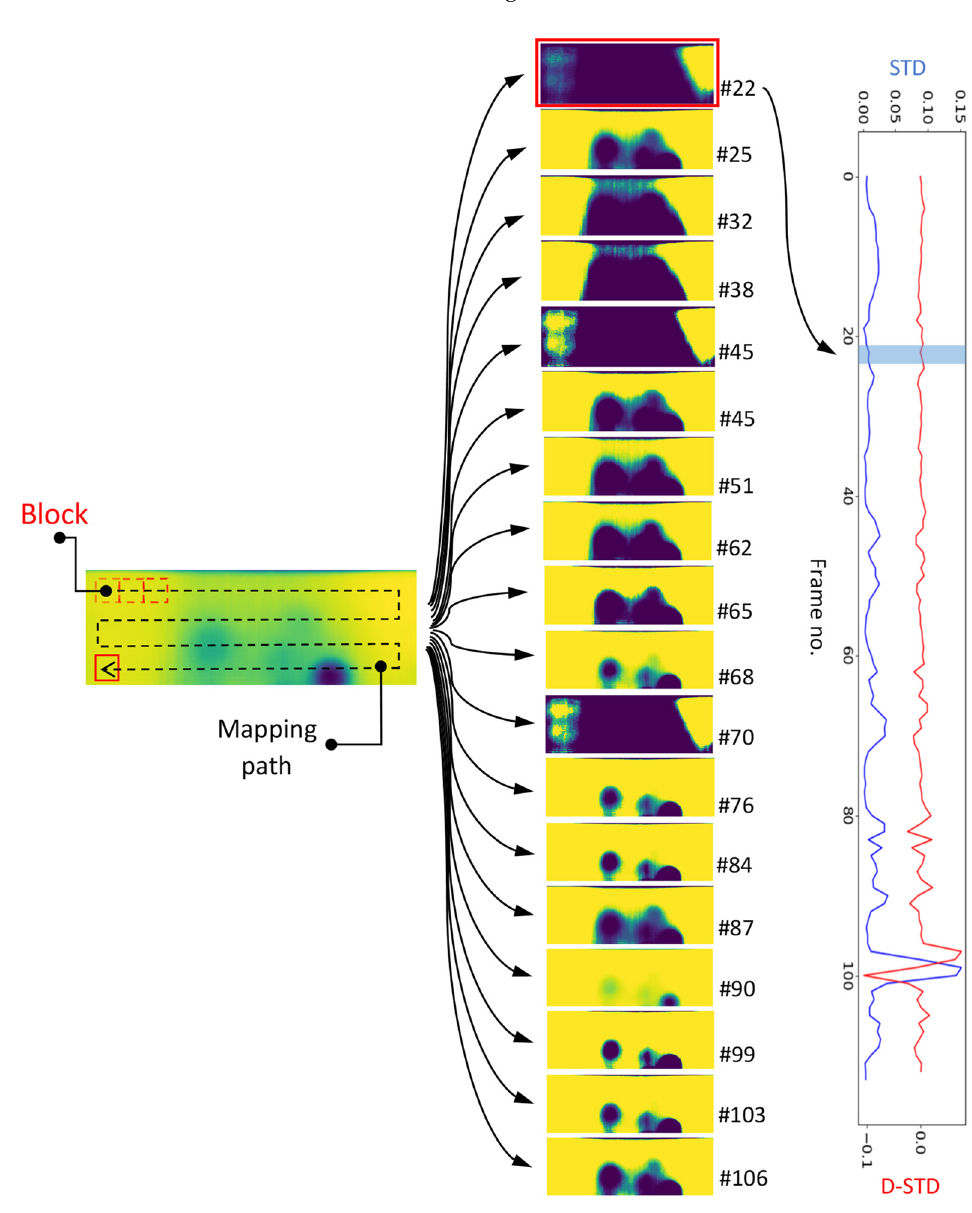
Figure 7. An example of a pre-processed original thermal image subject to a 40 × 40 mapping block and its DRR selected images based on block standard deviation threshold.